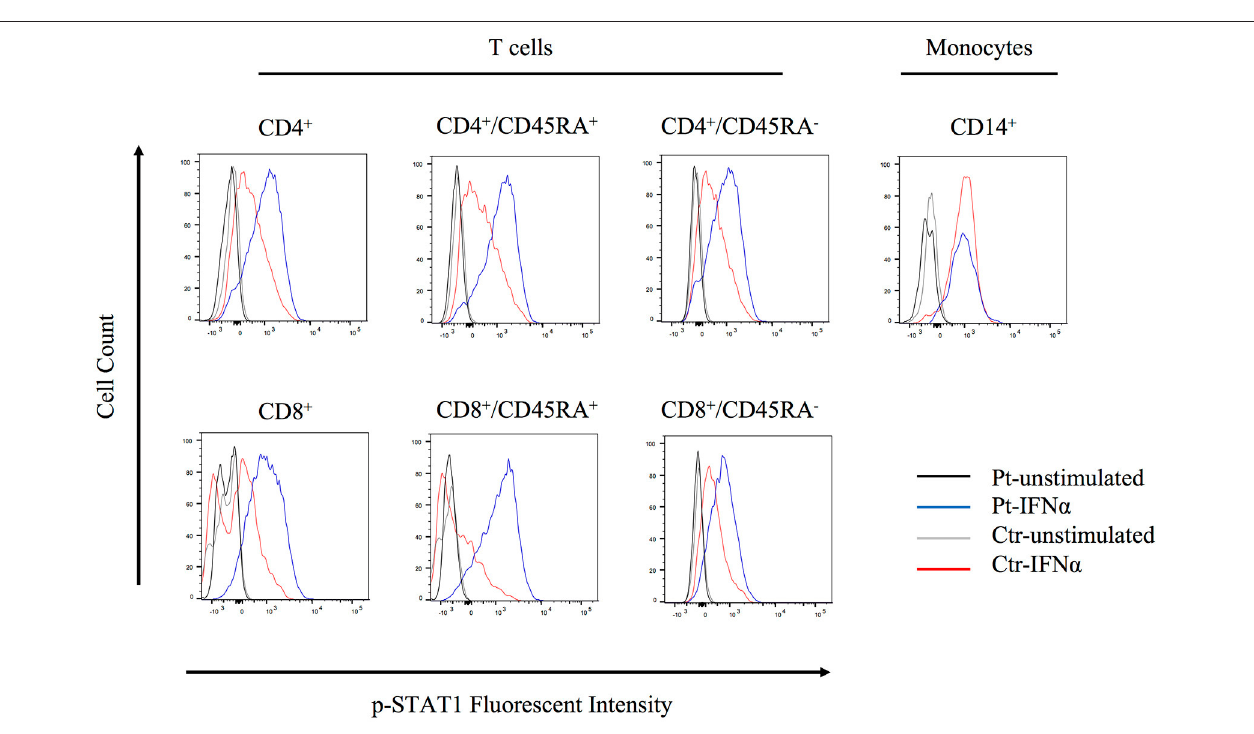
FIGURE 5 | Flow cytometry analysis of STAT1 phosphorylation. PBMCs were stimulated with IFN α 2 (20ng/ml) for 20min and CD4 + , CD8 + , and CD14 + cells were assessed for STAT1